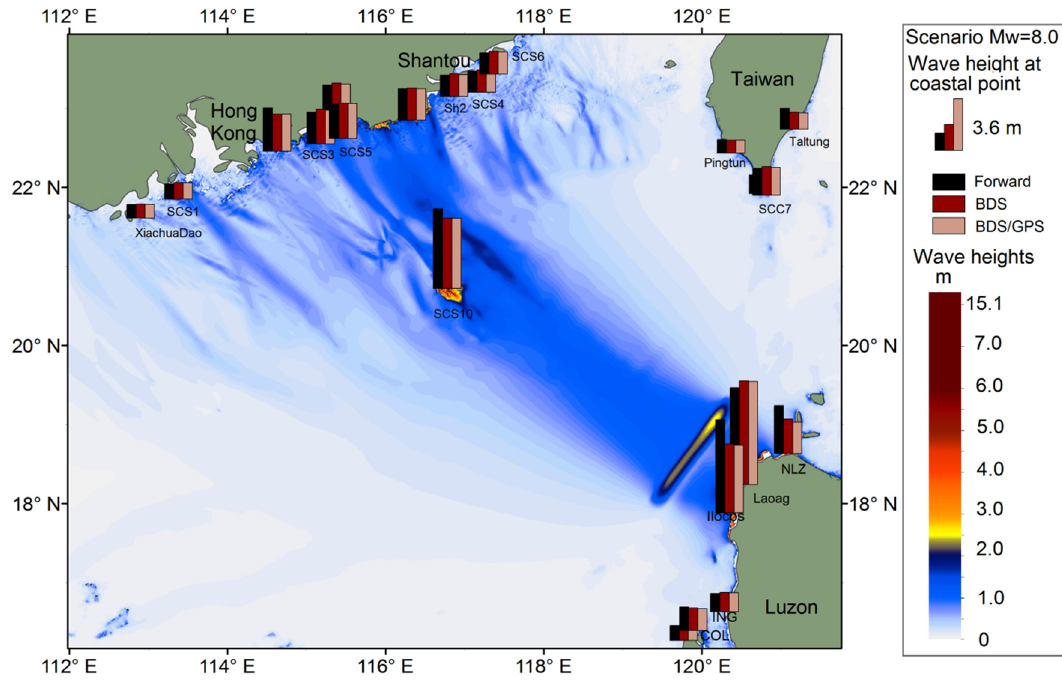
Figure 5. Simulated tsunami scenarios. The color map shows the maximum wave height in the forward model (Figure 4a) after 6 h of tsunami propagation. Vertical bars are maximum wave heights as recorded at selected coastal locations for the three propagation models: forward model (black); with source as inverted from BDS-displacements (dark grey in Figure 4b); with source as inverted from joint BDS/GPS-displacements (light grey, Figure 4c).